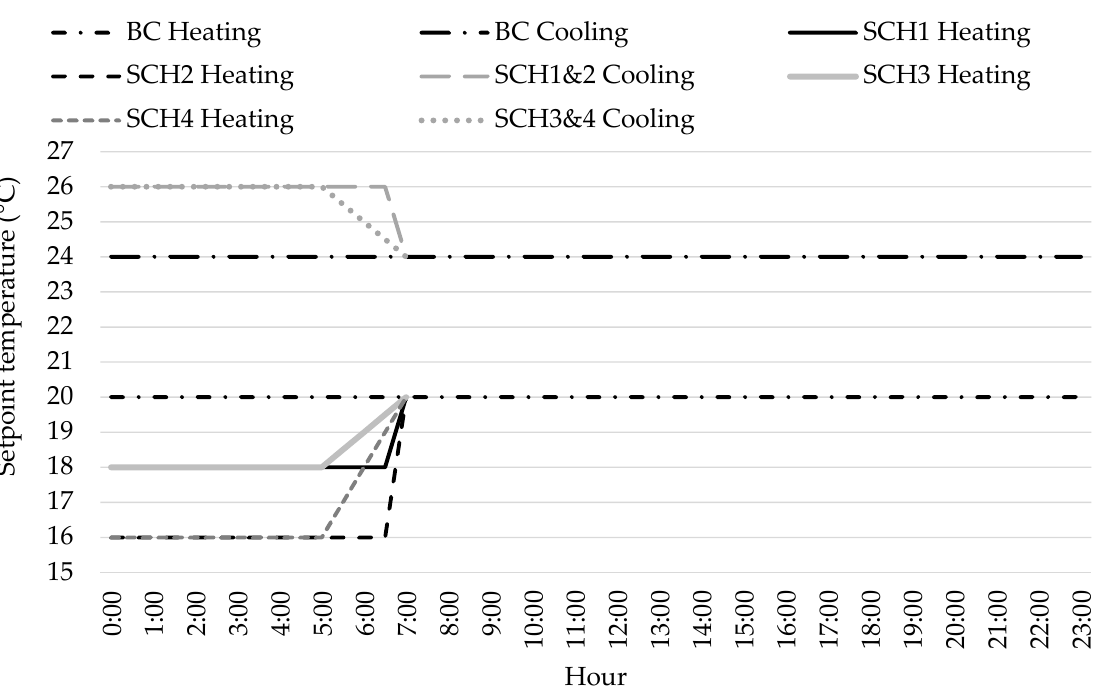
Figure 3. Heating and cooling schedules.